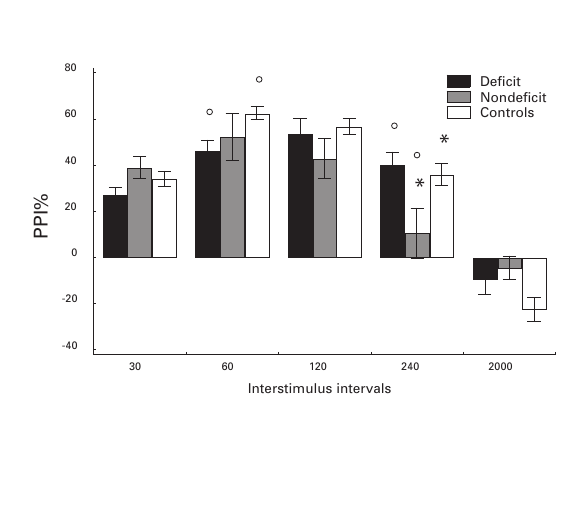
Comparison of schizo- phrenia with deficit syndrome (N = 46), schizophrenia with nondeficit syndrome (N = 21), and controls (N = 44): The deficit group exhibited sig- nificantly reduced PPI in the pp 60 condi- tion (p <0.0004), more- over deficit patients showed reduced facili- tation in pp 2000 (p <0.04), whereas pa- tients with nondeficit syndrome showed re- duced PPI in pp 240, compared to the deficit syndrome group and to controls (p <0.001).